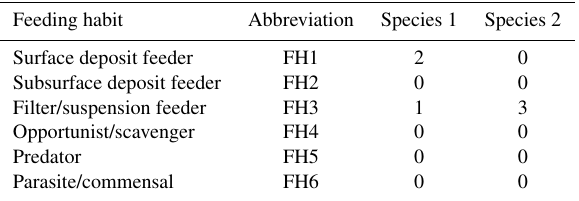
Table 5. Two coding examples for the trait “Feeding habit”, which has six trait categories (FH1–FH6; see also Table 3). Species 1 is a surface deposit feeder but can switch from facultative to suspension feeding, while species 2 is an exclusive suspension feeder.